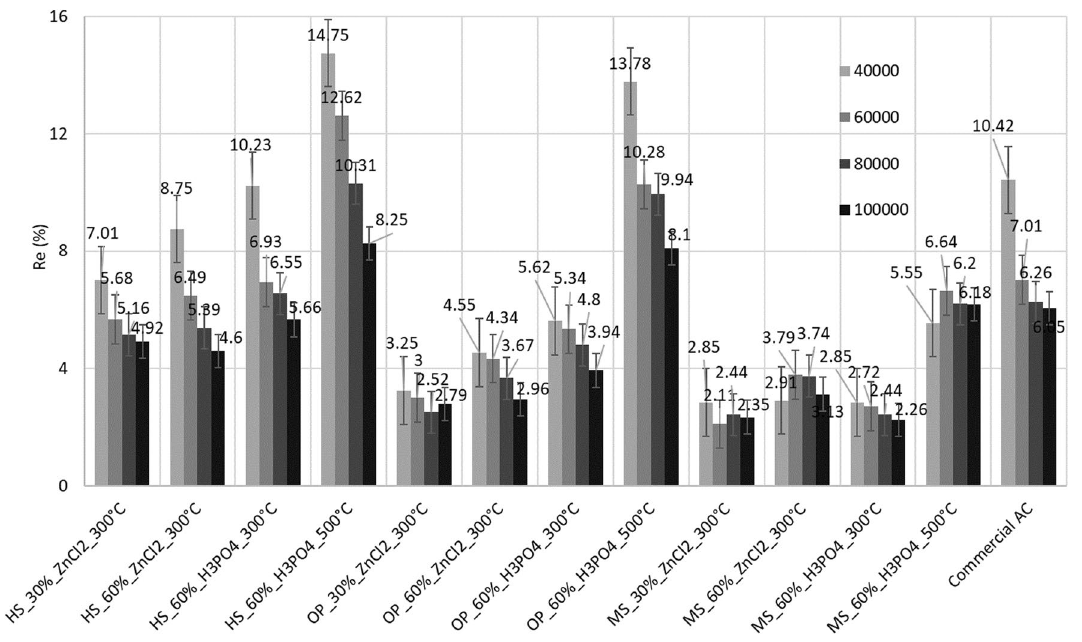
Fig. 1 Removal efficiencies (%) of various activated carbons for different initial concentrations of acetic acid solutions (mg/L)—error bars repre- sent standard